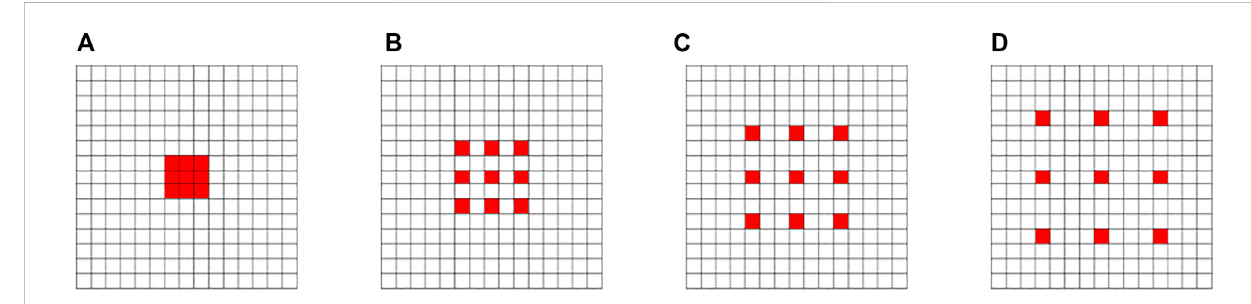
Atrous convolution with different dilation rates. (A) Dilation rate of 1; (B) Dilation rate of 2; (C) Dilation rate of 3; (D) Dilation rate of